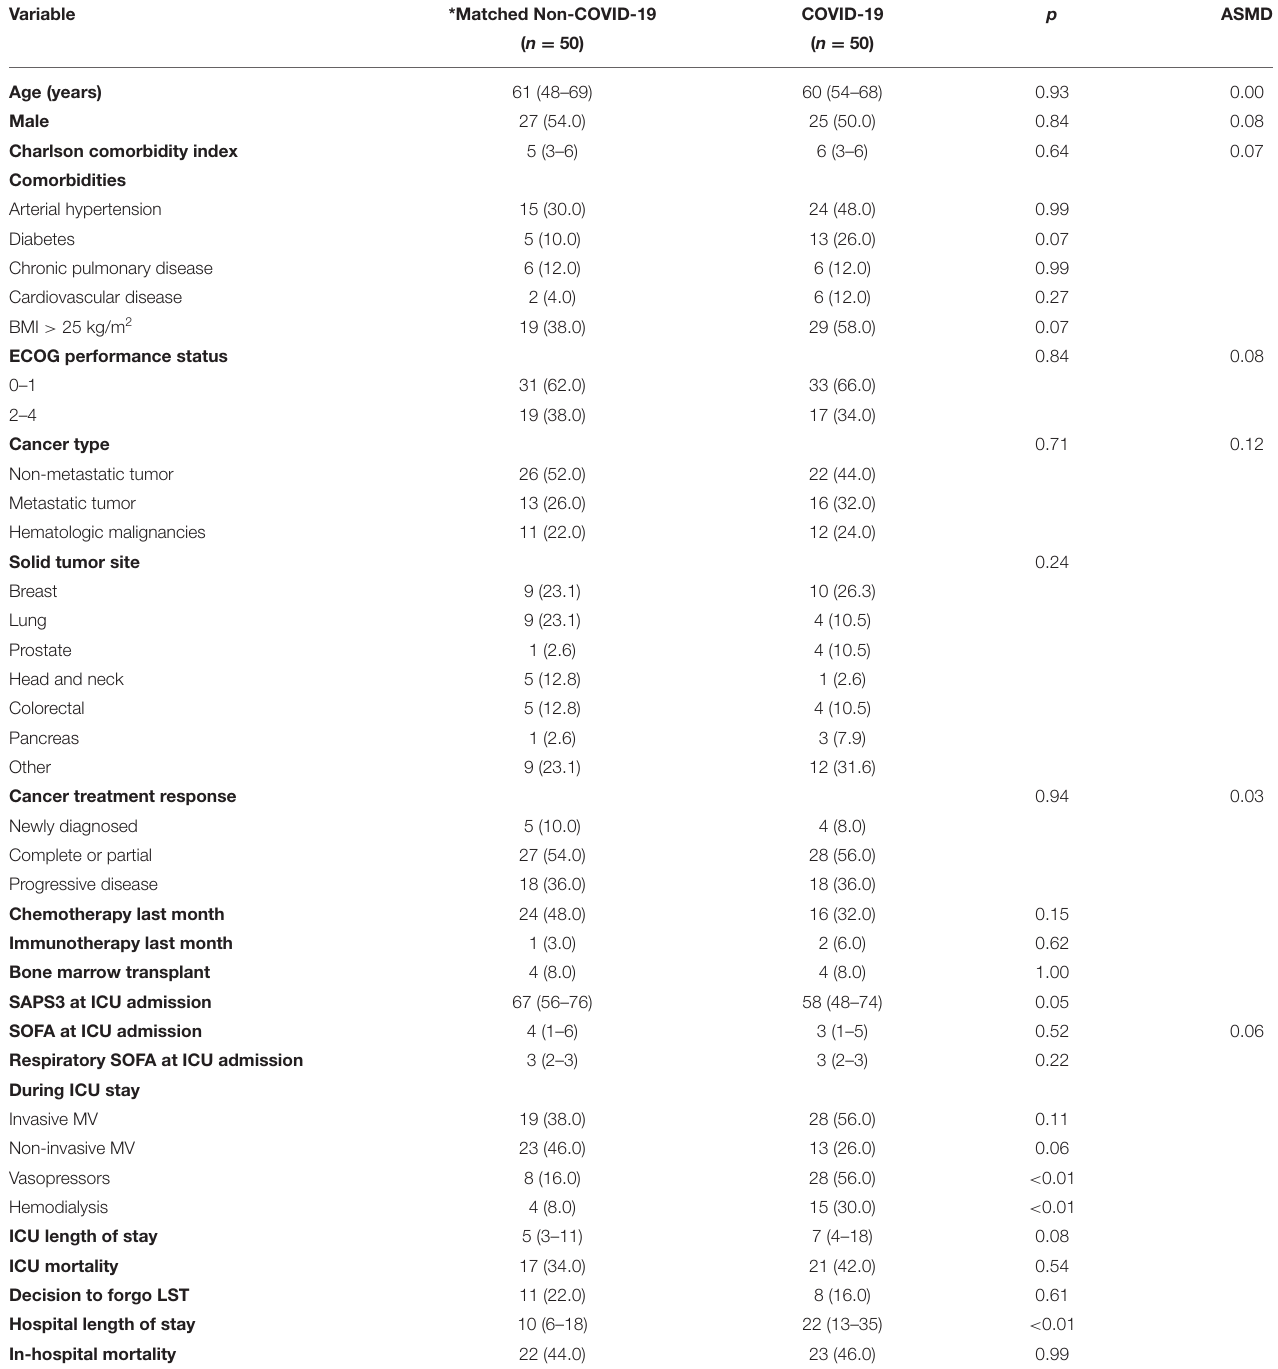
TABLE 3 | Comparison of patients with cancer and COVID-19 acute respiratory failure with matched patients with non-COVID-19 acute respiratory failure. Variable *Matched Non-COVID-19